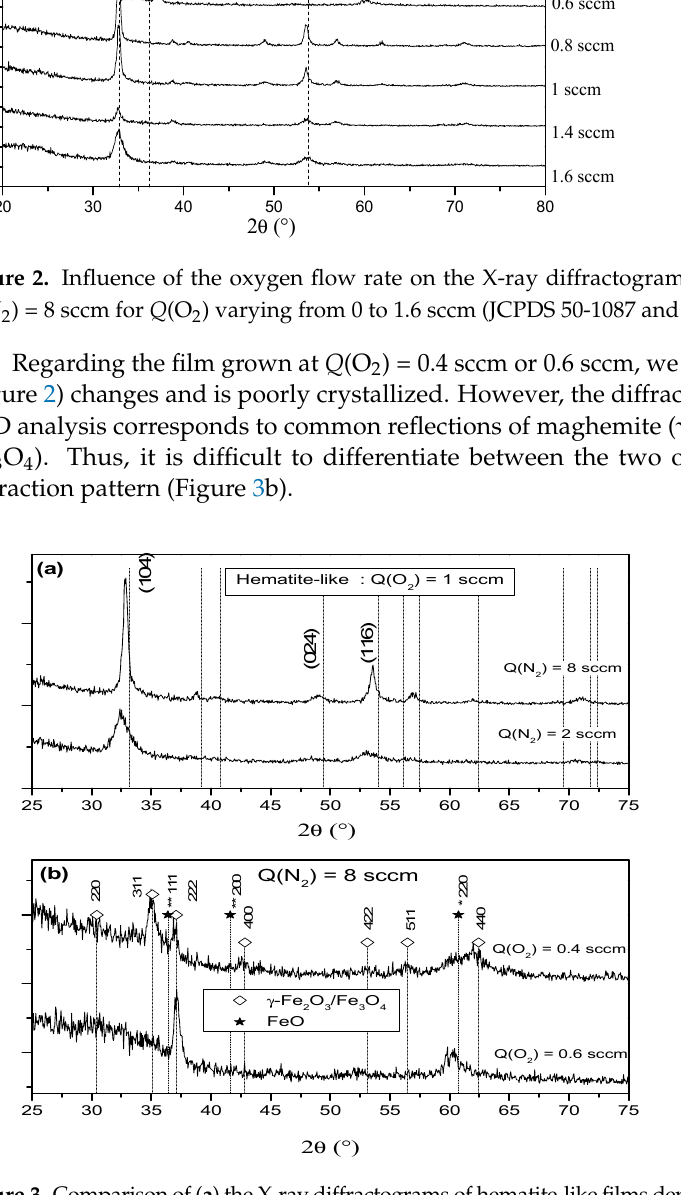
Figure 3. Comparison of ( a ) the X-ray diffractograms of hematite-like films deposited with Q (N 2 ) = 2 sccm and Q (N 2 ) = 8 sccm for Q (O 2 ) = 1 sccm and ( b ) X-ray diffractograms of γ -Fe 2 O 3 /Fe 3 O 4 deposited with Q (O 2 ) = 0.4 sccm and Q (O 2 ) = 0.6 sccm for Q (N 2 ) = 8 sccm (JCPDS89-0596).